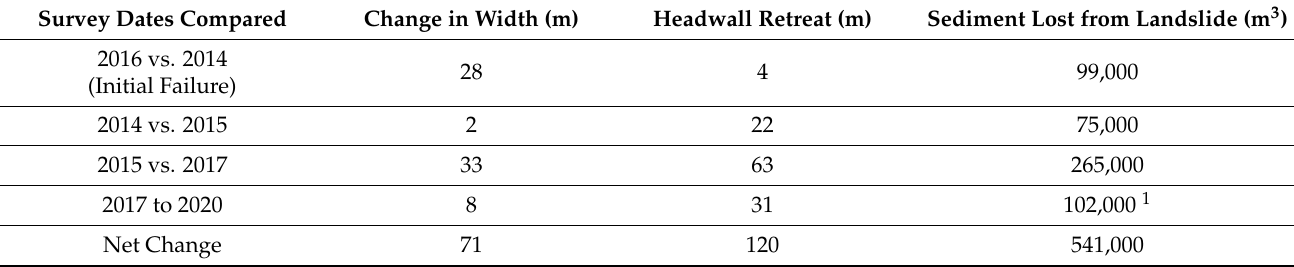
Table 1. Changes to landslide scar dimensions measured from DEMs of the study site (2006, 2014, 2015, 2017). The deficit volume implies the minimum volume of sediment lost from the scarp area over the stated time period. This change does not take into account the sediment accumulating in the bowl between major flushes resulting from large cliff collapses. Survey Dates